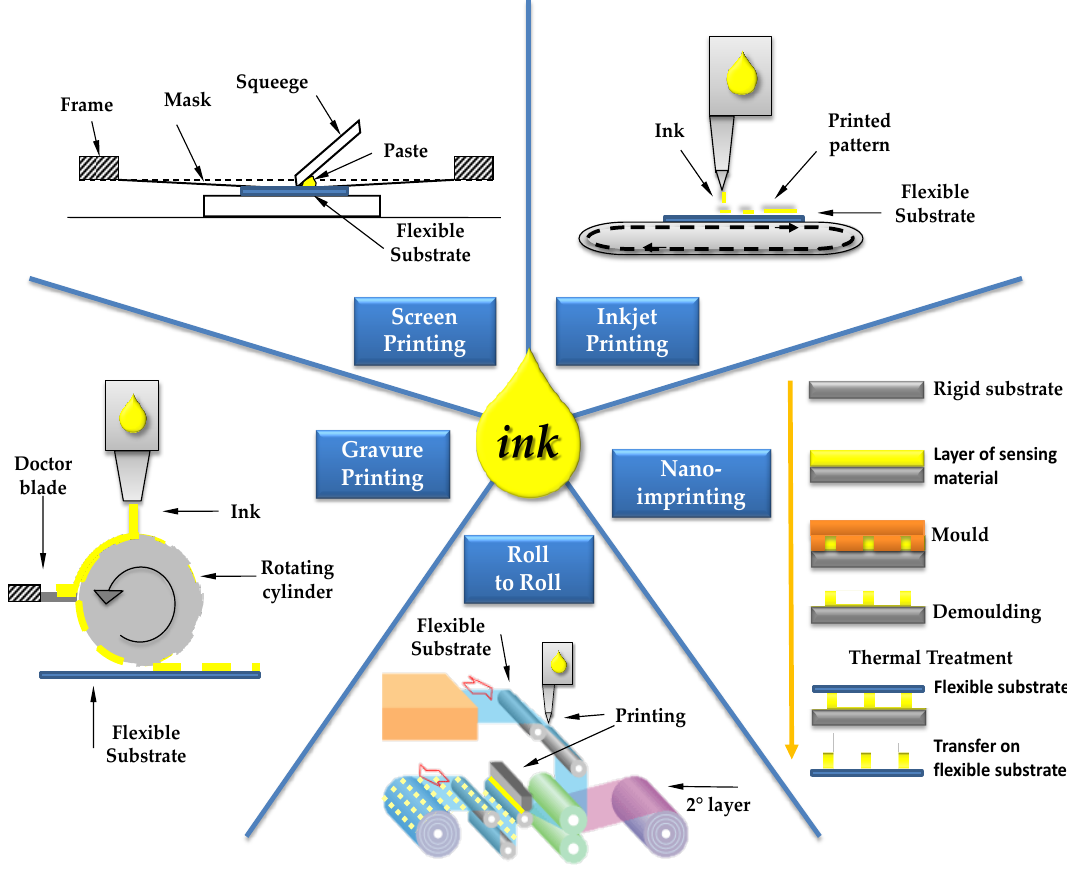
Figure 5. Scheme of the most used printing techniques to prepare chemiresistive gas sensors on flexible substrates.